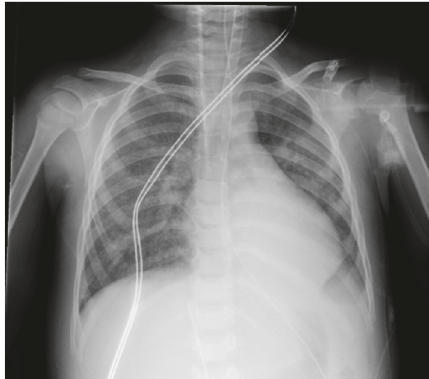
Figure 3: Follow-up radiograph. Improvement in pulmonary dis- ease from previous image five days following admission and treat- ment. Mild perihilar consolidation persists with basal